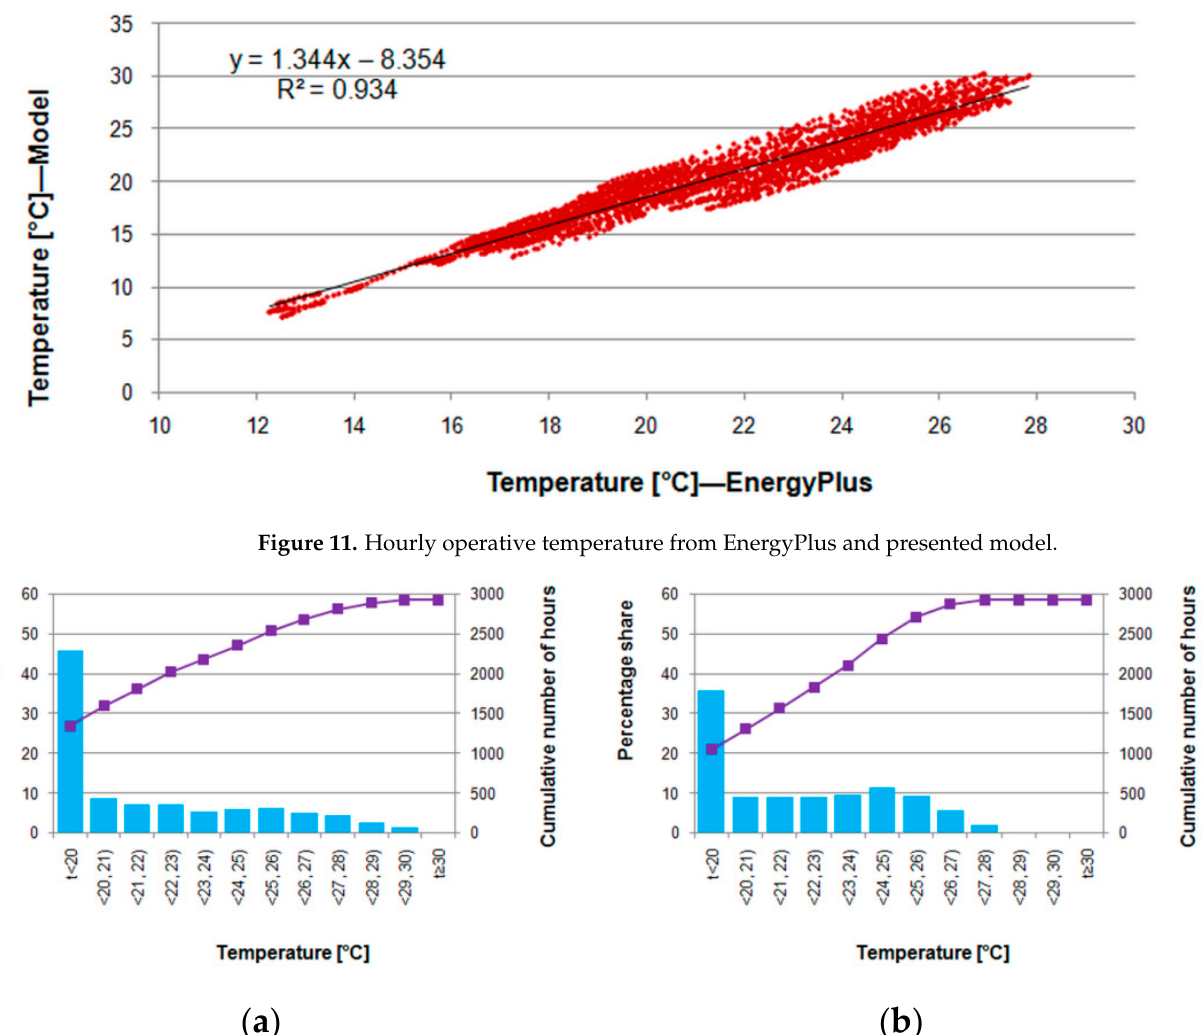
Figure 12. Histograms of operative temperature: ( a ) the model of EN ISO 13790; ( b ) EnergyPlus simulation.